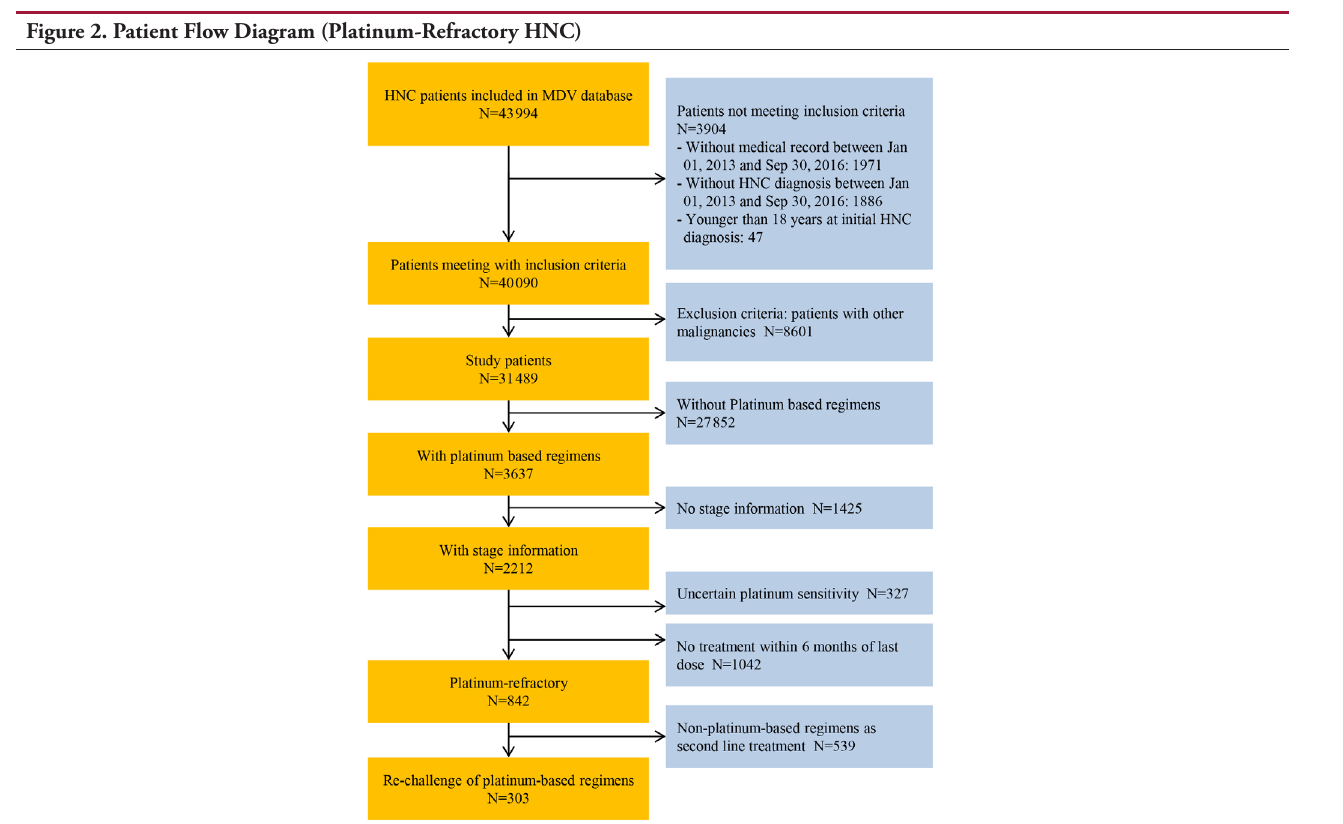
Abbreviations: HNC, head and neck cancer; MDV, Medical Data